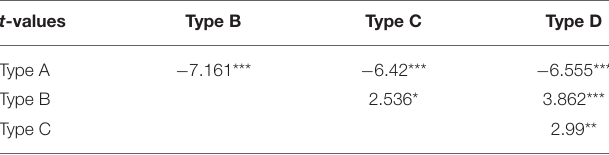
TABLE 4 | Results of paired sample t -test on reading time.